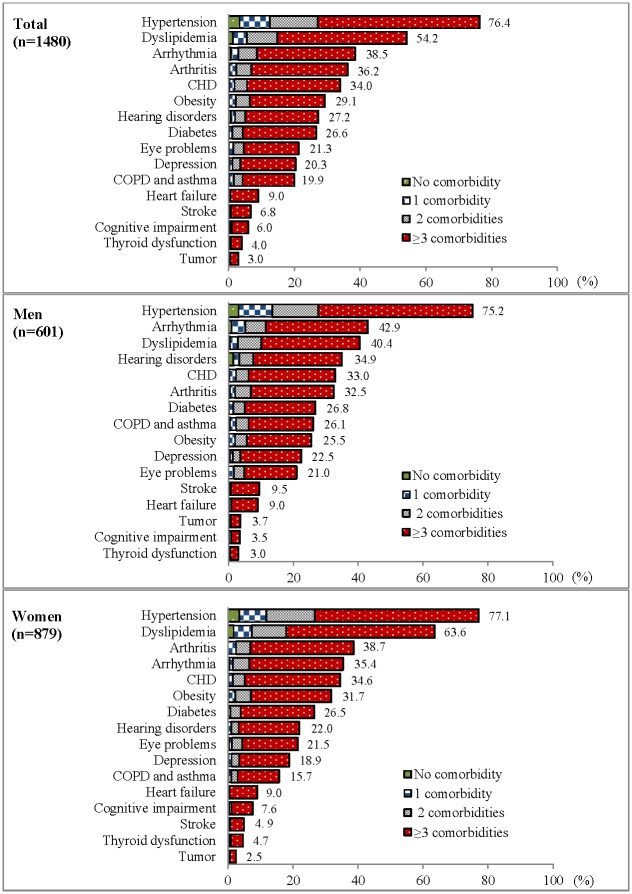
Prevalence (per 100) and co-occurrence of chronic diseases (n = 1480).Abbreviations: COPD, chronic obstructive pulmonary disease; CHD, coronary heart disease.